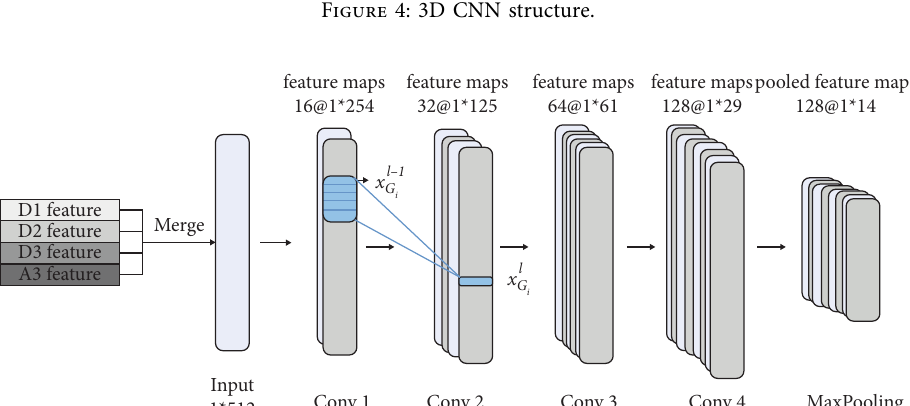
Figure 4: 3D CNN structure.